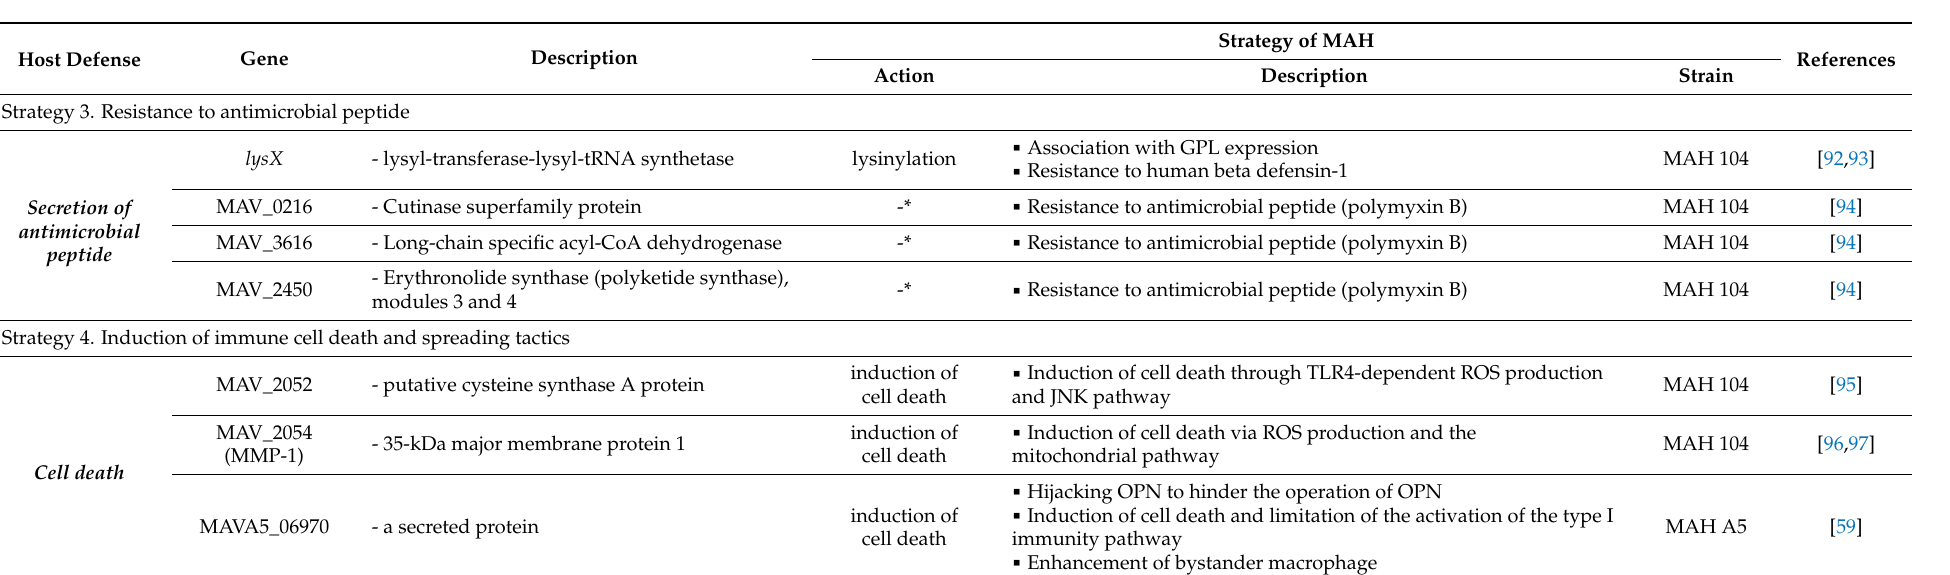
Table 2. Virulence-associated genes of Mycobacterium avium subsp. hominissuis during the pathogenesis.